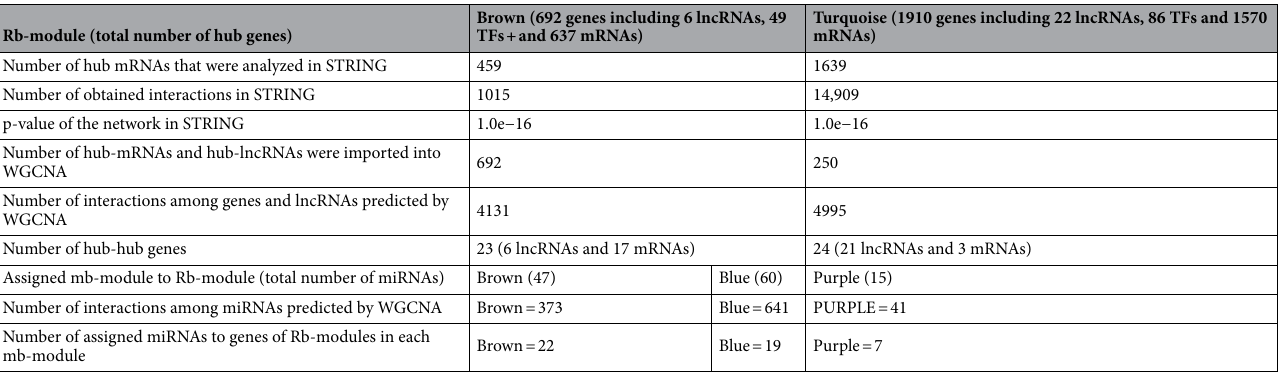
Table 3. The summary of the interactions in the integrated regulatory